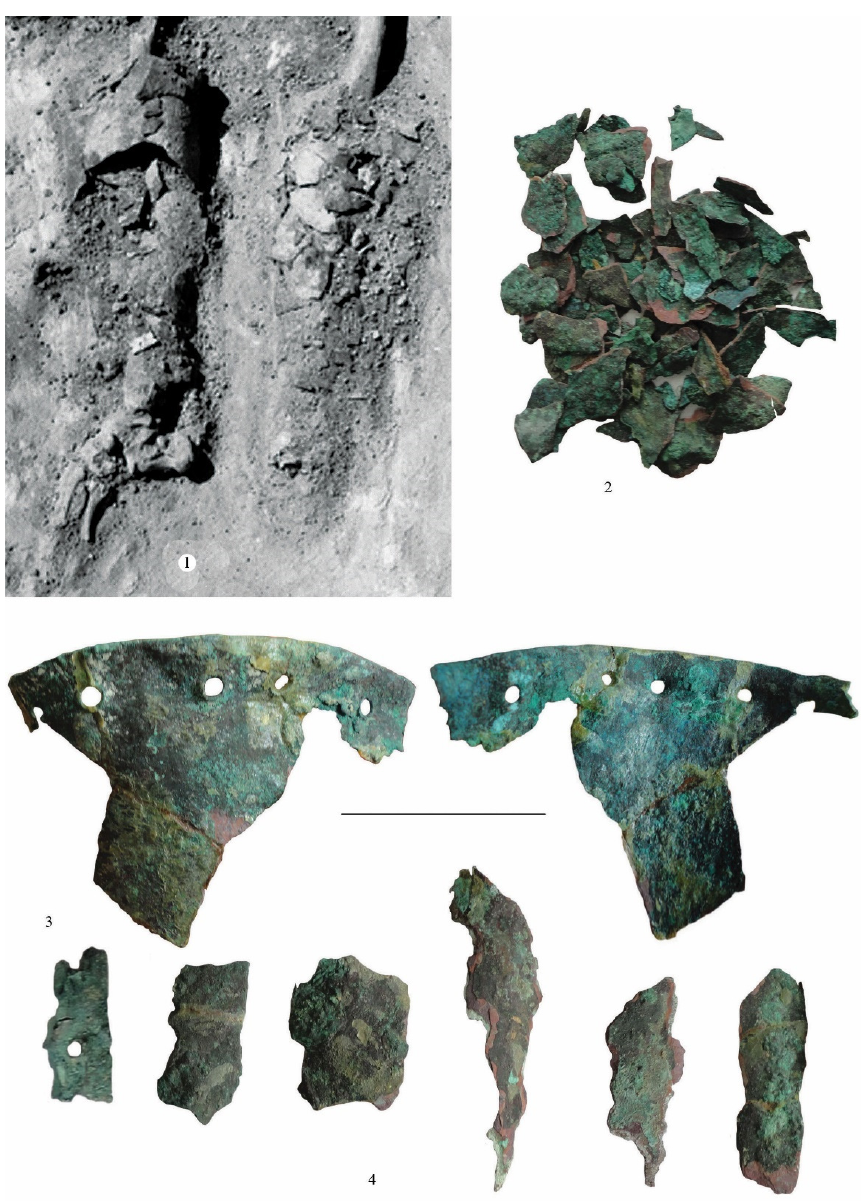
Figure 3. Vodoslavka Barrow 6 Burials 1–2. (1)—The greaves on a man’s legs; (2)–(4)—Fragments of the left greaves; (3)—Upper edge of greaves; (4)—Fragments of the “body” of the greaves (1— photograph from field report; 2–4—photograph М . Daragan).